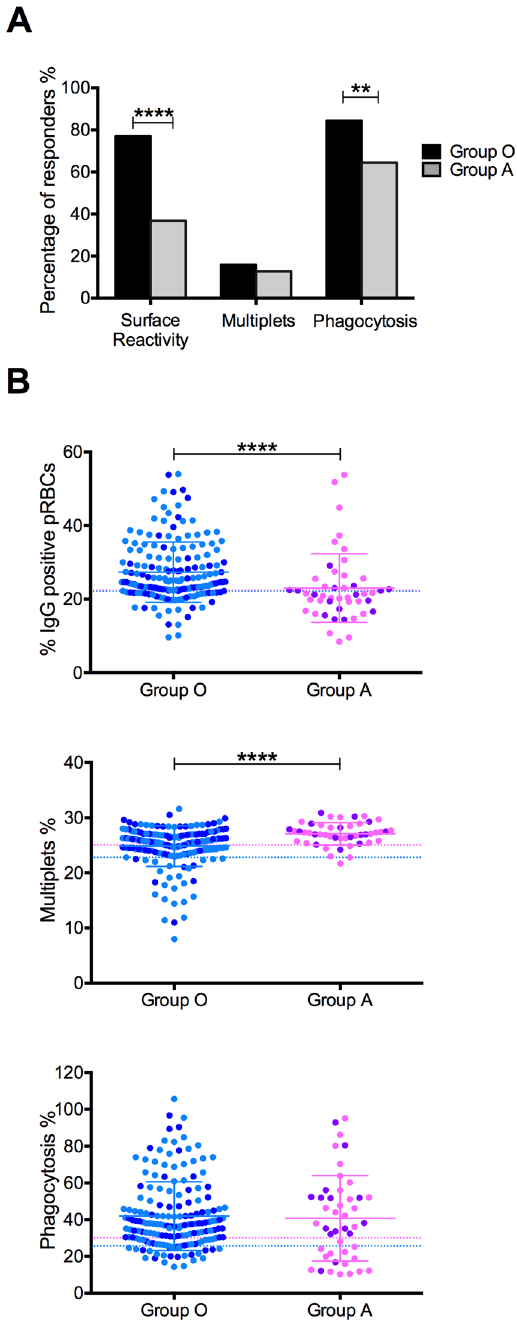
Figure 4. Comparison between the surface reactivity (measured as percentage of IgG positive pRBCs), the rosetting rate (measured as percentage of multiplets) and the percentage of phagocytosis in the presence of pediatric sera when the pRBCs tested were grown in group O vs. group A RBCs. ( A ) The percentage of positive responders for each variable is depicted. Differences between the percentages for each group were determined using a chi-square test. ( B ) Measurements for each of the variables are represented and grouped by blood group used to grow the parasites tested. Differences between the two groups were determined using a Mann-Whitney unpaired